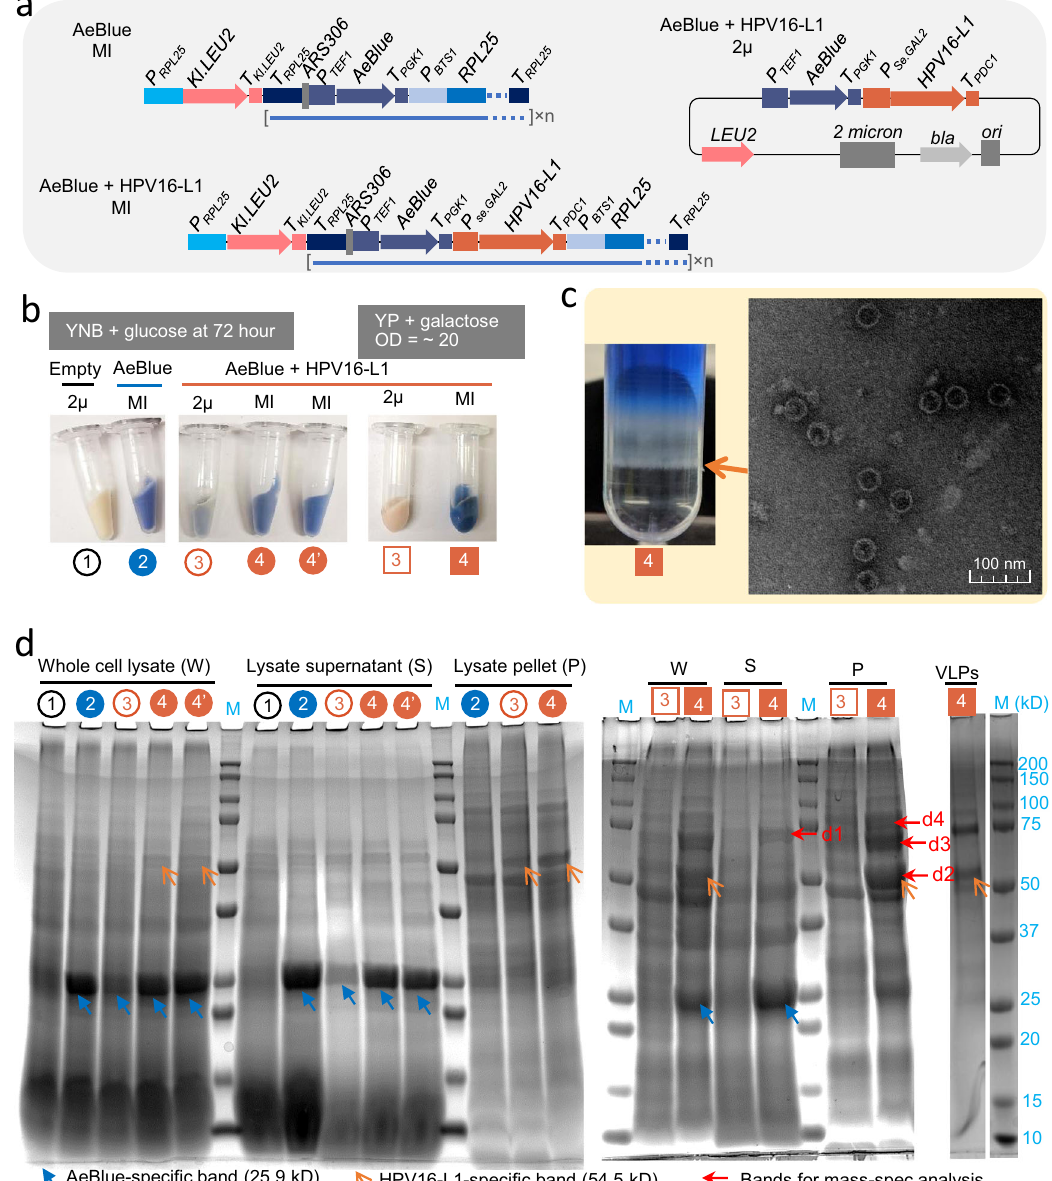
Fig. 6 Characterisation of the expression of heterologous proteins (AeBlue and HPV16 capsid L1) via multi-copy genome integration (MI) using P BTS1 - RPL25 -driven in vivo gene ampli fi cation. a Schematic of genetic vectors used to express AeBlue and HPV16 L1. b cells harbouring an empty 2 μ , the ampli fi able AeBlue construct (MI), AeBlue-and-HPV16-L1 2 μ plasmid, and ampli fi able AeBlue-and-HPV16-L1 construct (MI). Cells were grown in MES- buffered YNB medium with 20 g l − 1 glucose and collected at 72 h, or were grown in YP medium with 20 g l − 1 galactose to OD 600 = ∼ 20. c Ultracentrifugation of the supernatant on an iodixanol gradient to separate a band containing HPV16-L1 virus-like particles (shown by orange arrow), and transmission electron microscopy con fi rming the presence of HPV16-L1 virus-like particles (VLPs). d SDS-PAGE (sodium dodecyl sulphate- polyacrylamide gel electrophoresis) for whole-cell lysates, lysate supernatant, and lysate pellets of yeast samples in b , and VLPs sample from c . Experimental repetition is not done for c and d . Numbers in b – d are for sample cross-reference. The bands d1, d2, d3, and d4 are analysed using a LC-MS/ MS-based proteomic method (Supplementary Method 1), and the data are available in Supplementary Data 1 (d1), Supplementary Data 2 (d2), Supplementary Data 3 (d3), and Supplementary Data 4 (d4). Source data for VLPs in d are provided as a Source Data